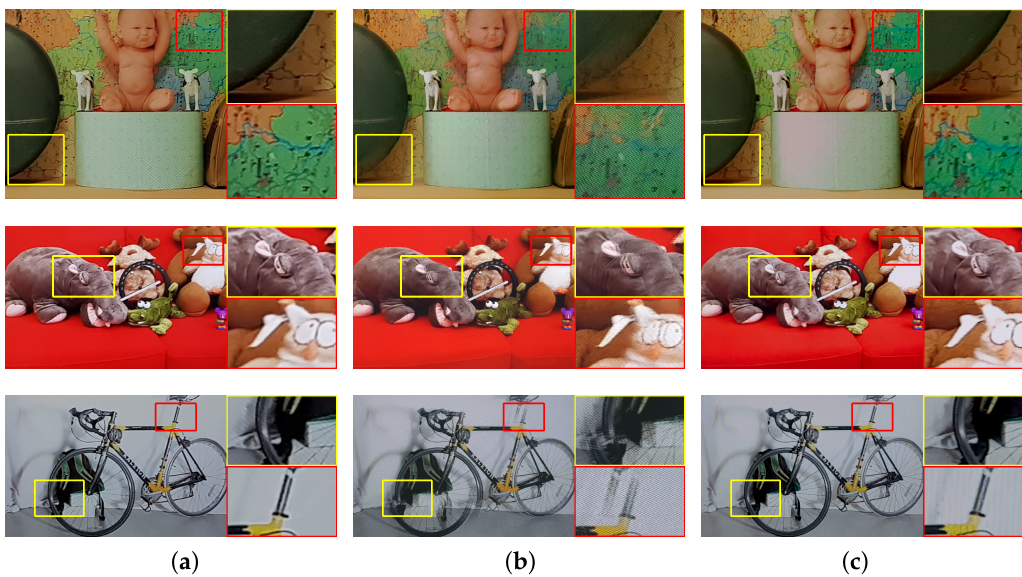
Figure 12. Example images observed on a real-life ETAD display. The images Lego Knights, Fish, Flower, Aloe, Motorcycle, Baby3, Couch, and Bicycle1 (from top to bottom) were rendered using the parameters from our designed method and the calibration results: ( a ) reference; ( b ) no calibration; and ( c ) calibration using the proposed